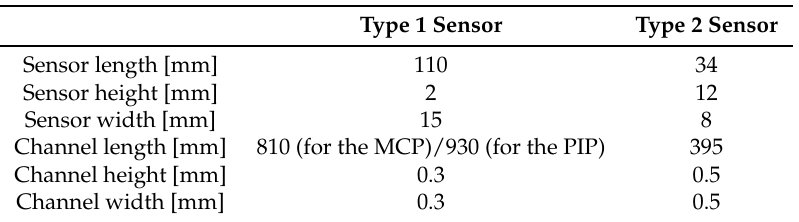
Table 1. Specification of Type 1 and 2